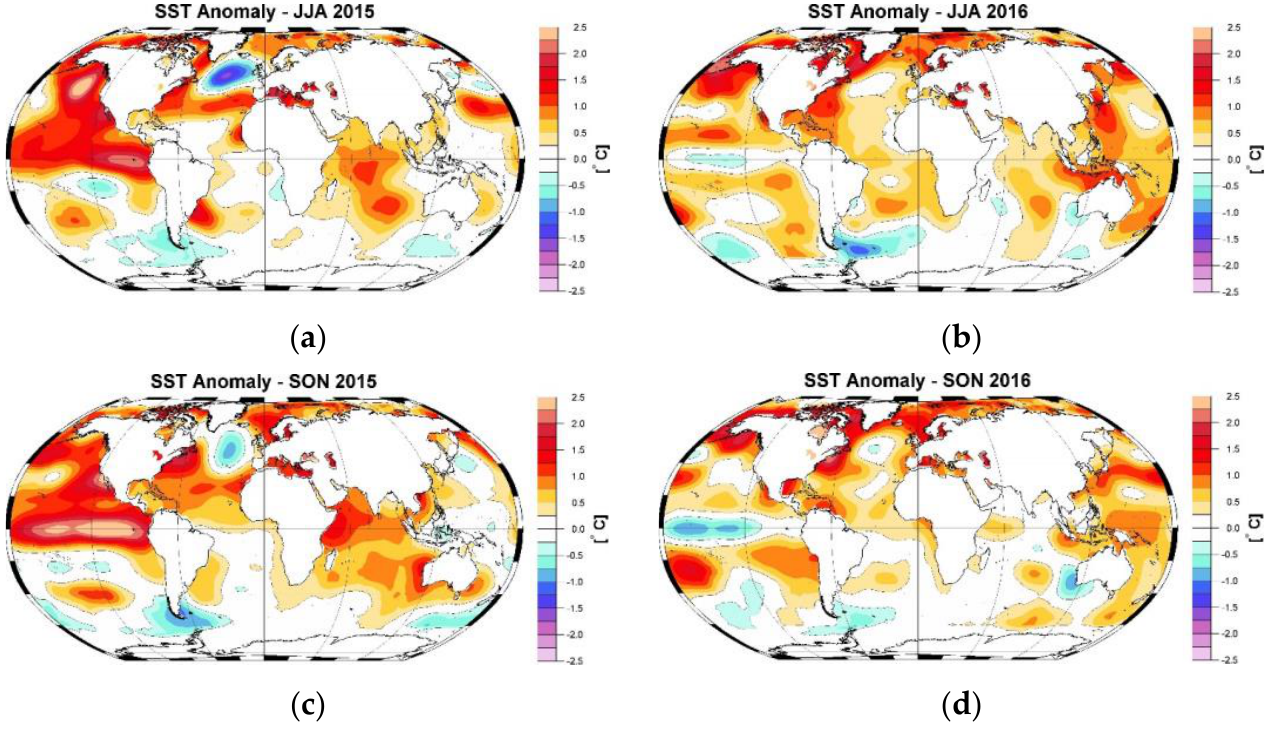
Figure 4. Sea surface temperature anomalies for: ( a ) summer (JJA) 2015; ( b ) summer 2016; ( c ) autumn (SON) 2015; and ( d ) autumn 2016.